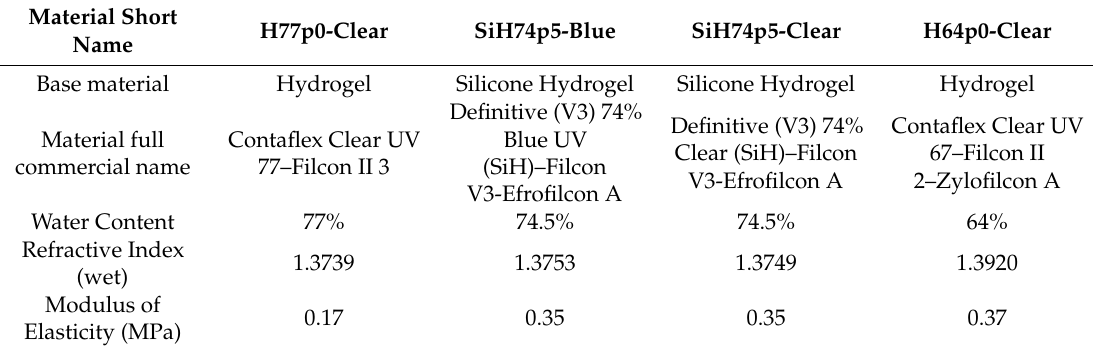
Table 2. Empirical data provided by Contamac for each of the four hydrogel materials.